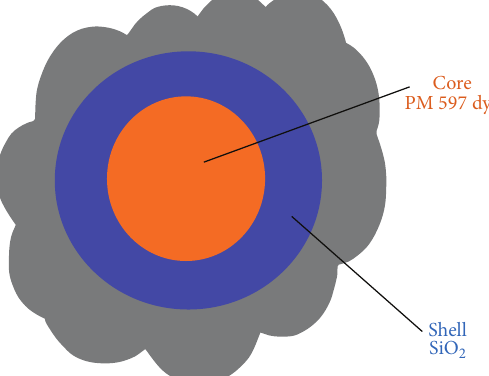
Figure 1: Schematic nanostructure of PM dye/SiO 2 core-shell NPs.